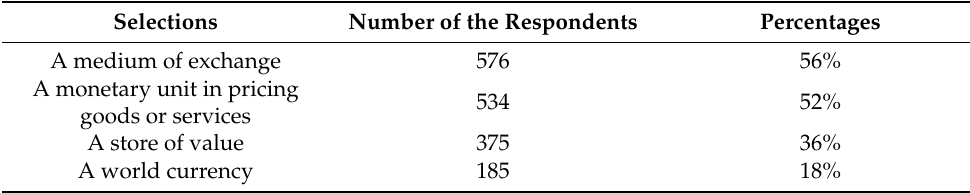
Table A12. What functions of currency do you think that cryptocurrencies have (multiple-choice question)?